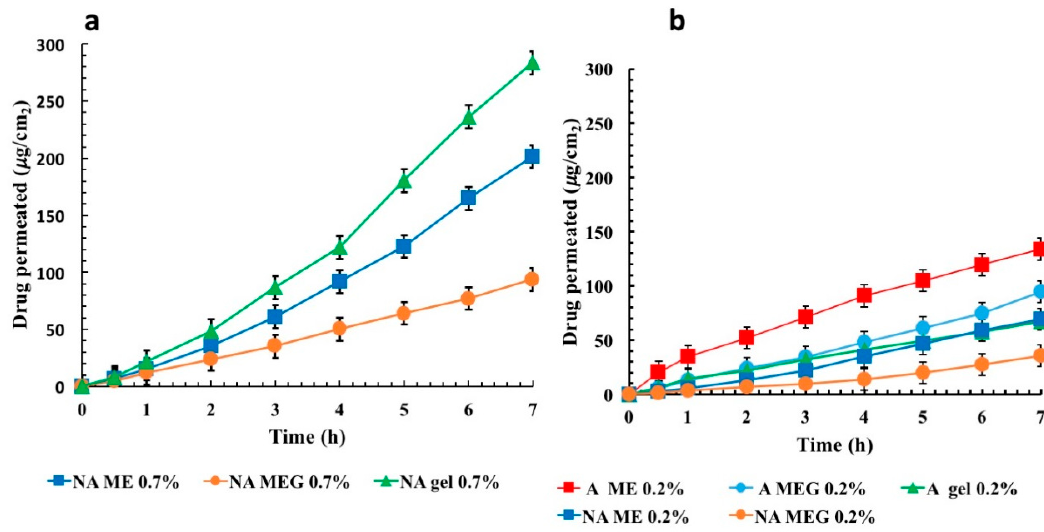
Figure 5. Cumulative amount of NA ( a ) and A ( b ) permeated from different samples through rabbit ear skin at 37 °C: ME ( ■ ), MEG ( ● ), plain gel ( ▲ ) (mean ± SD; n = 3).